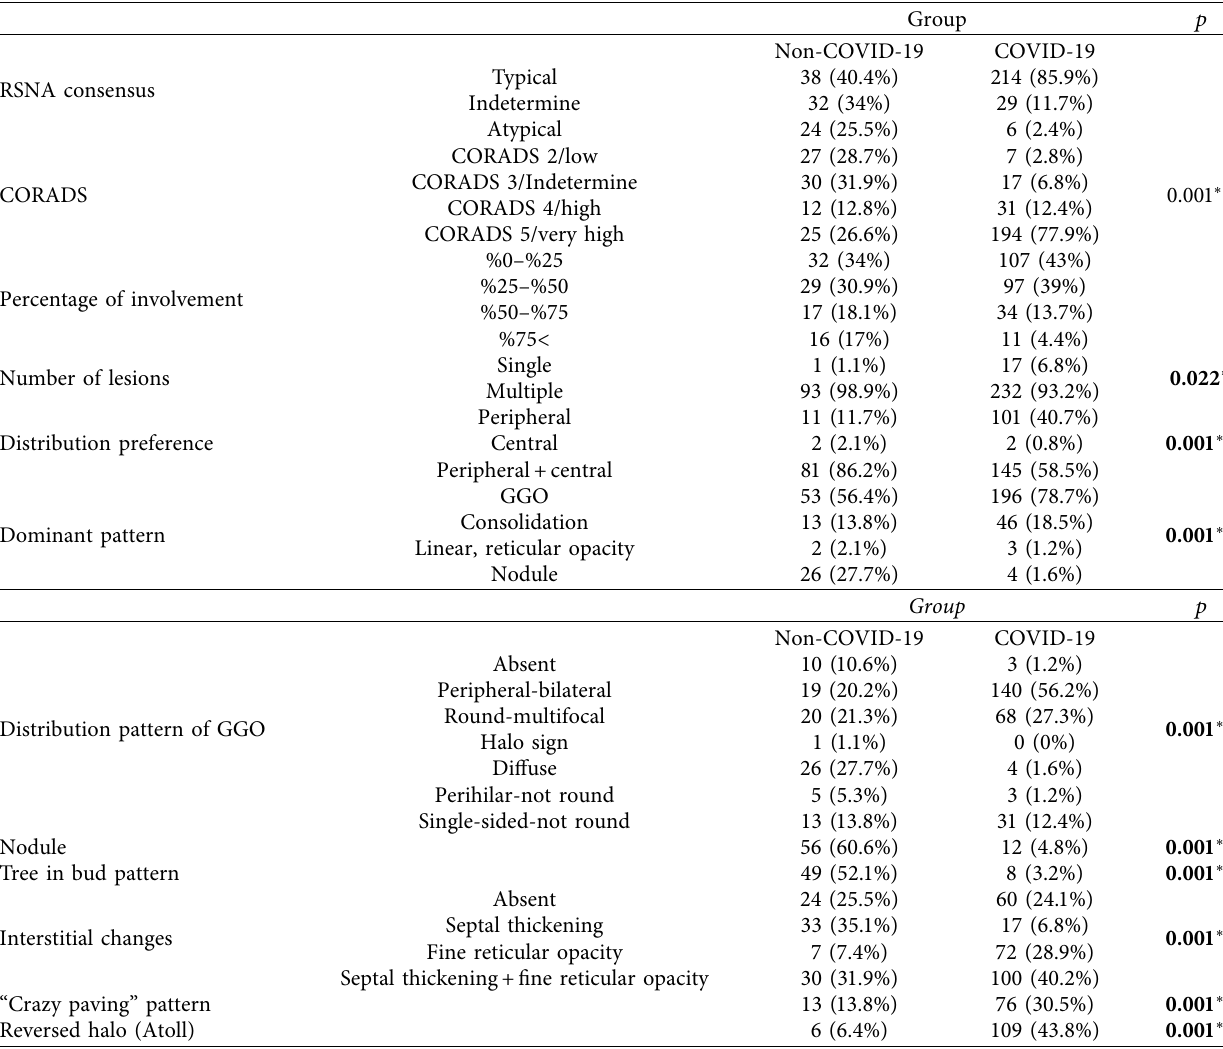
Table 2: Chi-square test analysis findings in relation between non-COVID-19 and COVID-19 groups in terms of RSNA consensus guide classification, CORADS scoring, and imaging findings of thorax computed